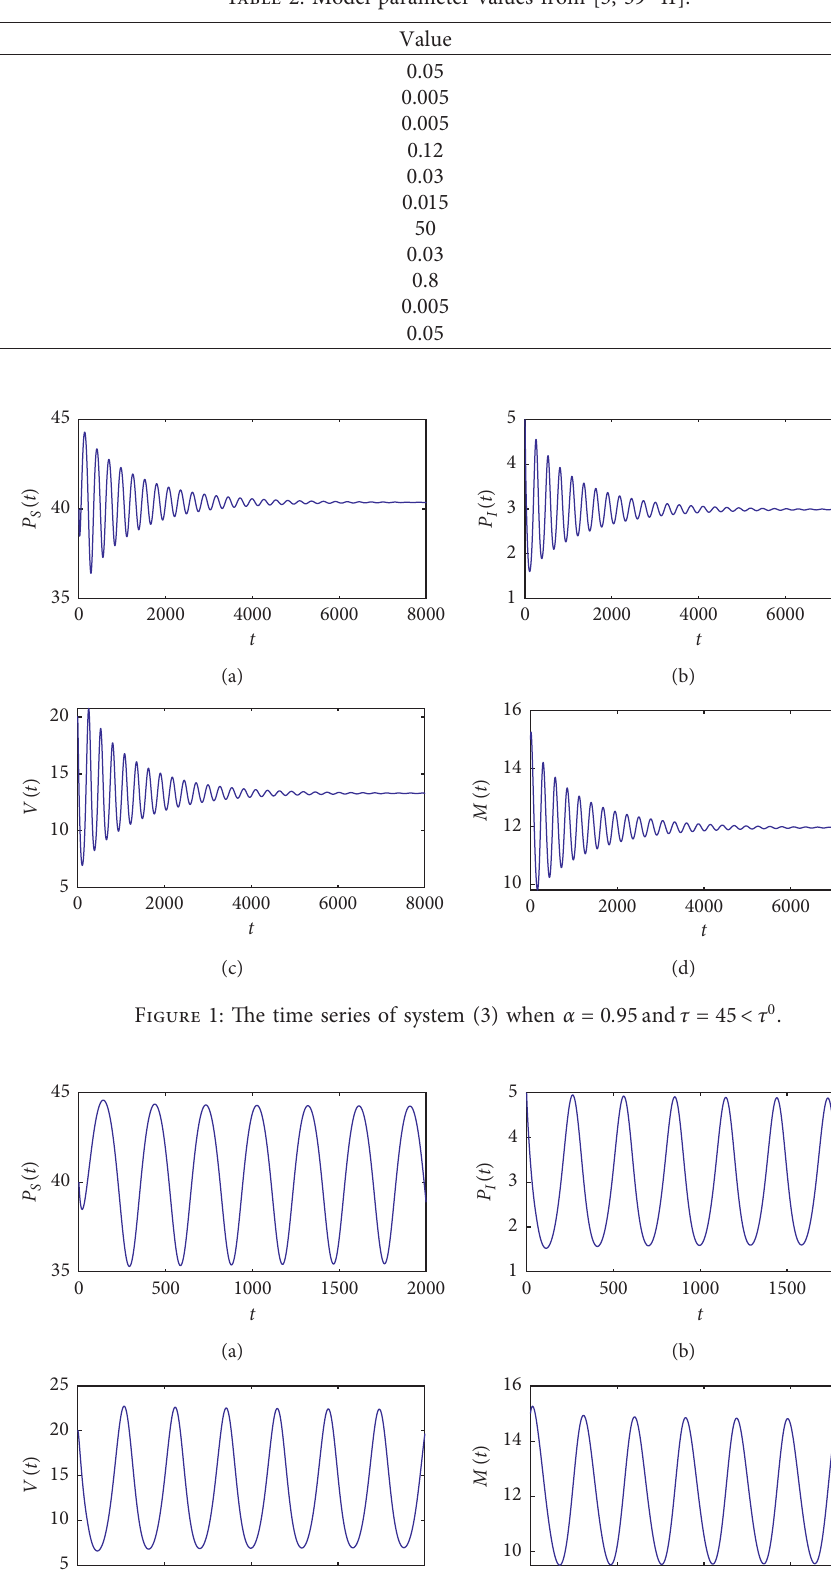
Table 2: Model parameter values from [3, 39–41].